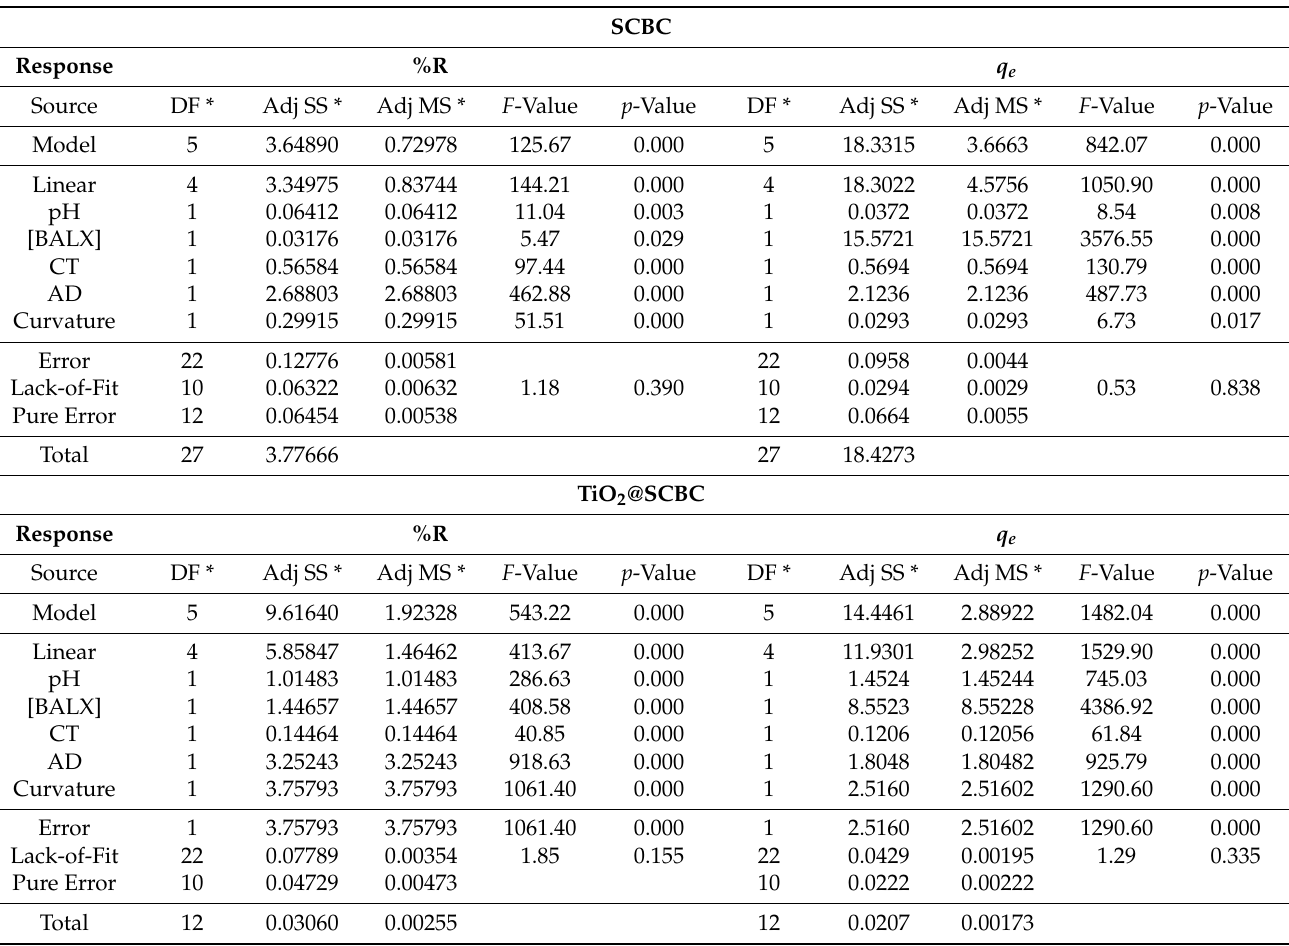
Figure 7. Pareto chart of standardized effects in case of %R (SCBC ( a ) and TiO 2 @SCBC ( b )) is the response to be optimized. Table 4. Analysis of Variance (ANOVA) testing